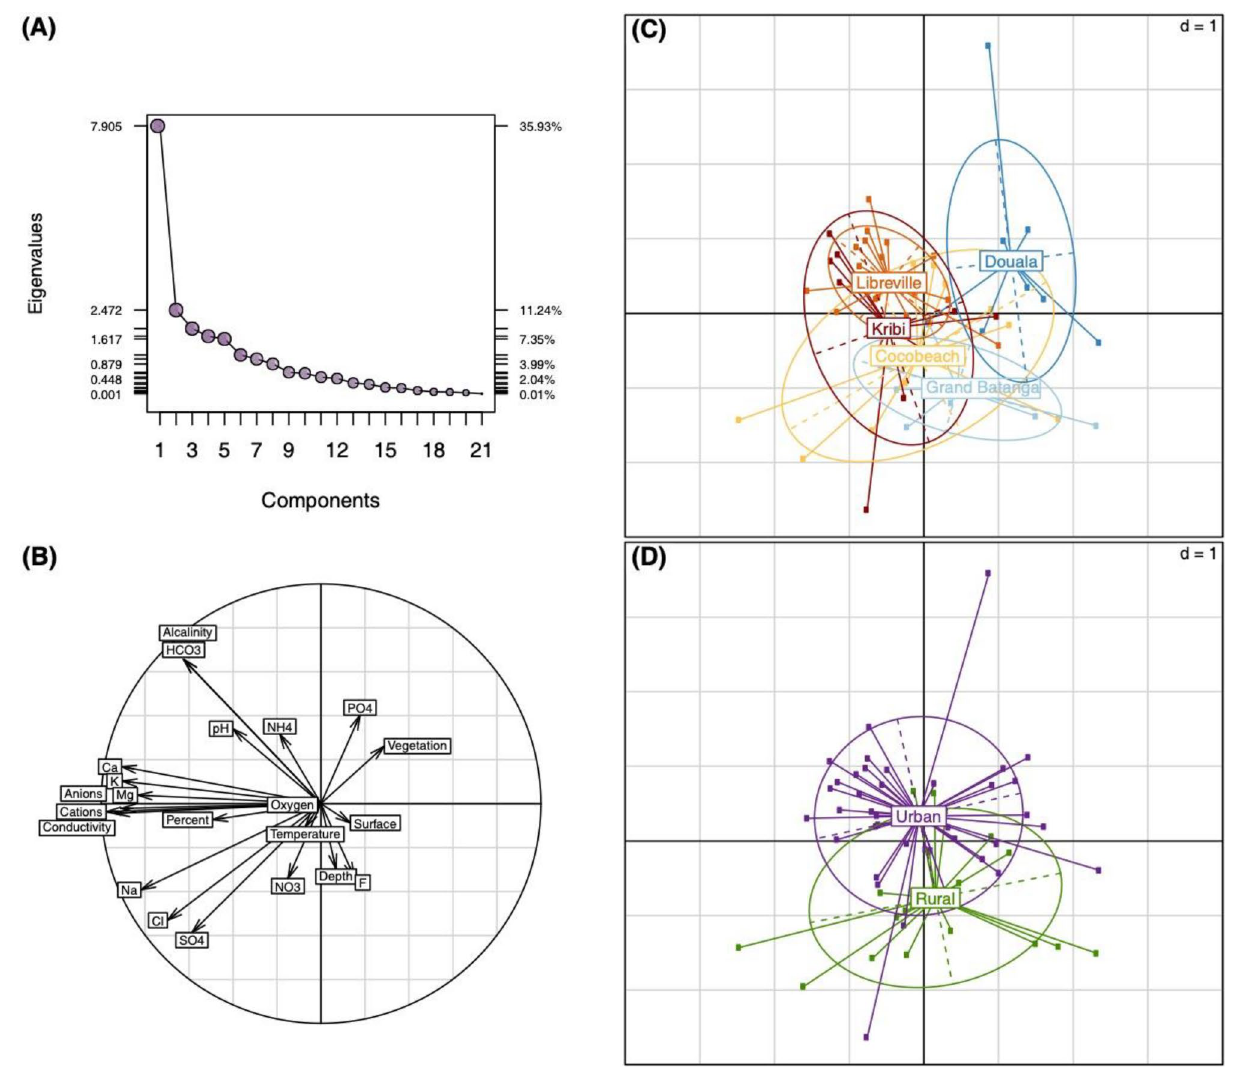
Figure 2. Breeding sites characterization according to the physico-chemical variables. ( A ) Principal components selected with the Broken Stick model. ( B ) Canonical weight of each variable on the principal components; the arrow size indicates the importance of the parameter. ( C ) and ( D ) PCA diagrams showing the correlations between rural and urban breeding sites and physicochemical characteristics.